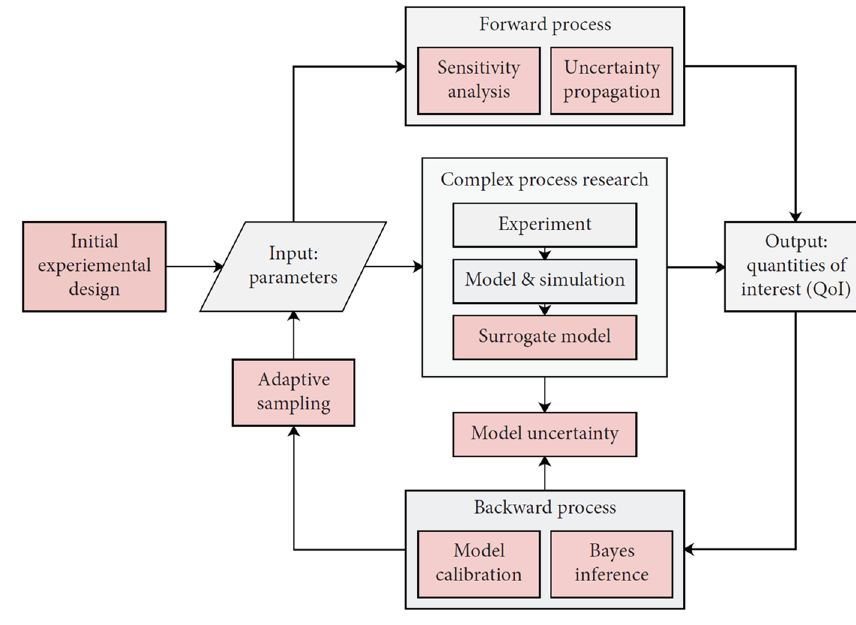
Fig. 7 Categories, classifica- tion, and correlation of com- mon defects and uncertainties within adhesively bonded